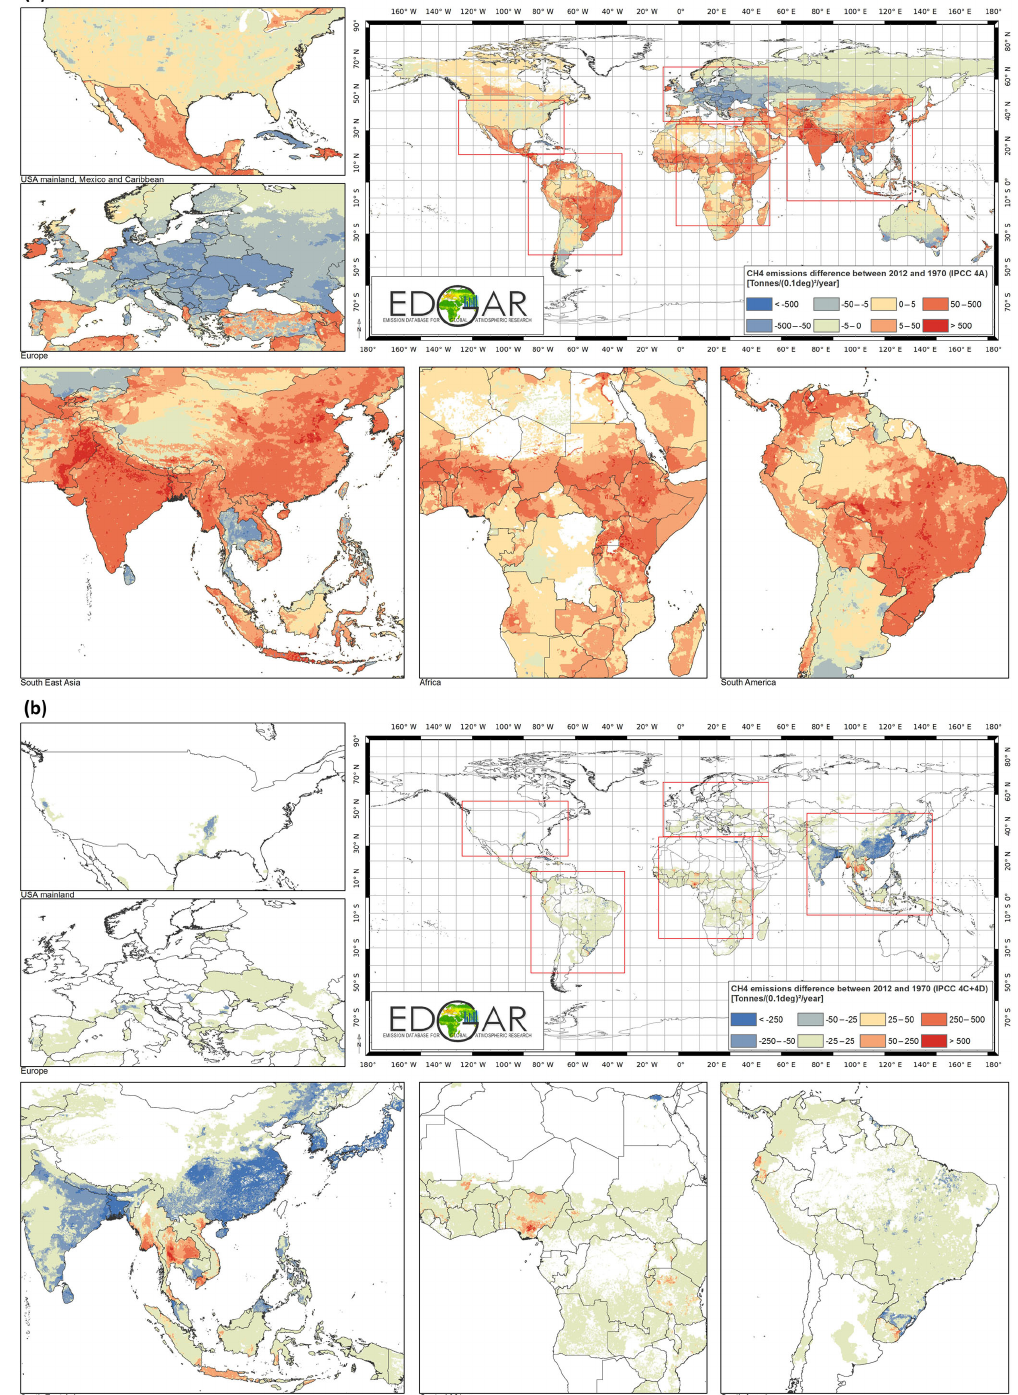
Figure 13. (a) Difference in CH 4 emissions from enteric fermentation between 2012 and 1970. (b) Difference in CH 4 emissions from rice cultivation between 2012 and